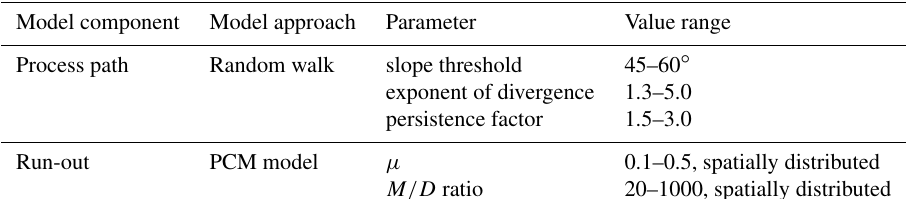
Table 4. Model configuration for avalanche modeling on a regional scale and approximate parameter ranges (compiled from Perla et al., 1980; Salm et al., 1990; Hegg, 1996; Heckmann, 2006; Schmidtner, 2012).